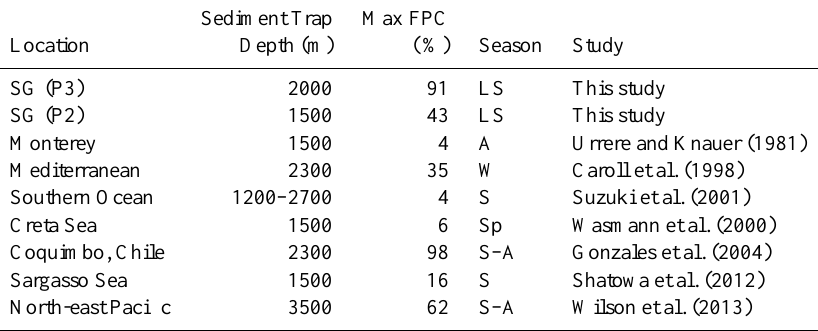
Table 2. Literature survey of maximum %FPC to total POC in sediment trap material. Note: S stands for summer, LS for late summer, A for autumn, Sp for spring and W for winter; SG stands for South